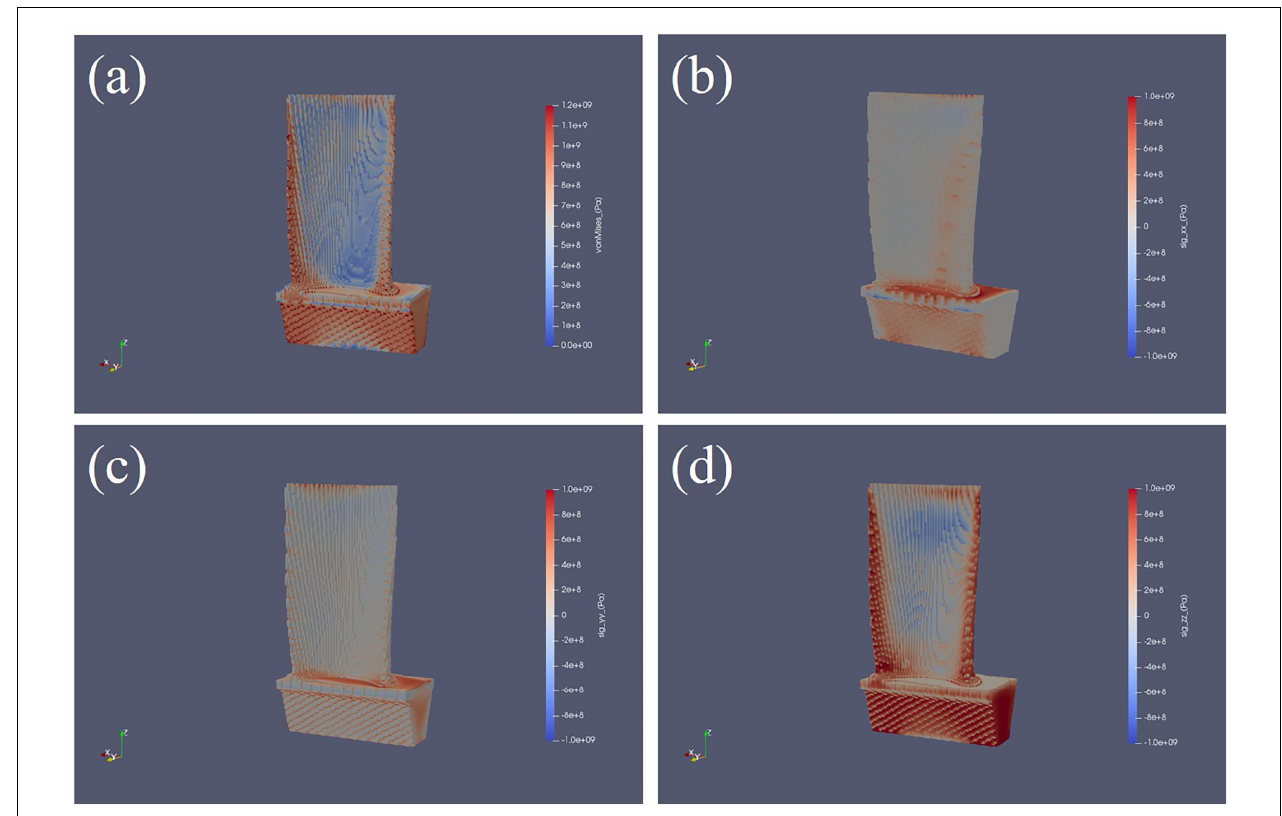
FIGURE 11 | Thermal stress distribution diagrams. (a) Equivalent stress distribution. (b) X-component of stress along the scanning direction. (c) Y-component of stress orthogonal to the scanning. (d) Z-component of stress along the building direction.